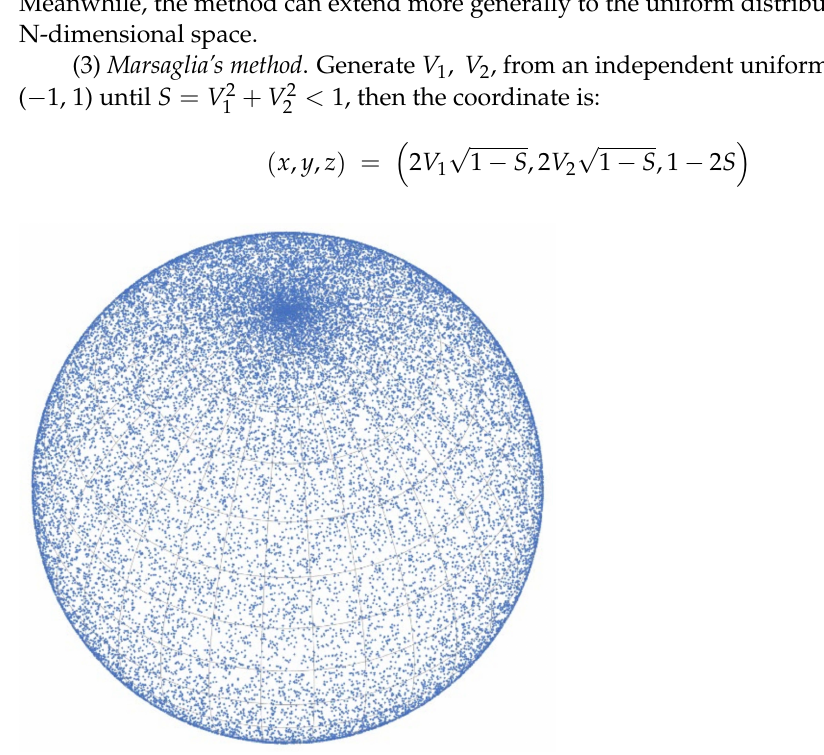
Figure 2. Incorrectly distributed